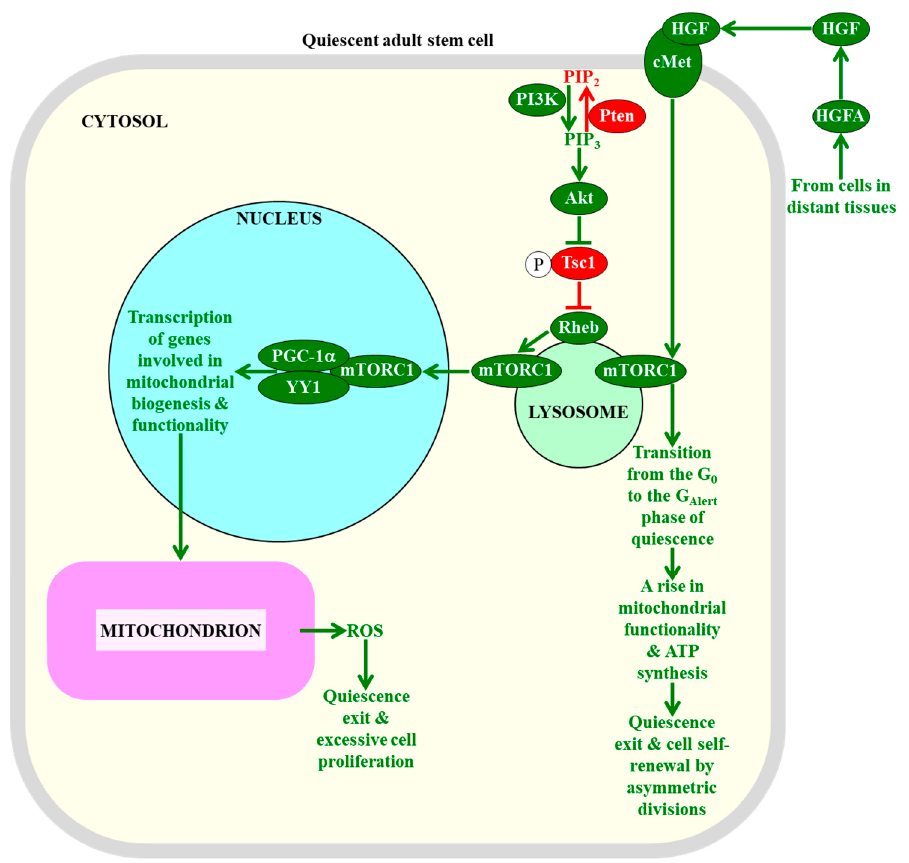
Figure 4. The intensity of information flow through the mTORC1-signaling pathway defines the fate of quiescent adult stem cells. A low intensity of mTORC1 signaling in adult stem cells decreases the extent of mitochondrial ROS production and release, thereby preventing the exit of these cells from the quiescent state and their excessive proliferation. An activation of mTORC1 signaling in response to hepatocyte growth factor, a cell-extrinsic pro-mitogenic signal, commits quiescent adult stem cells to cell cycle entry, proliferation, and differentiation. Proteins, metabolites, and processes whose activities, concentrations, and rates must be increased to maintain the quiescence of adult stem cells are displayed in red. Proteins, metabolites, and processes whose activities, concentrations, and rates need to be increased to promote the exit of adult stem cells from the state of quiescence are displayed in green. The red arrow defines the chemical reaction whose rate must be increased to maintain the quiescence of adult stem cells. The red inhibitory bar defines the inhibitory effect whose intensity must be increased to maintain the quiescence of adult stem cells. The green arrows define chemical reactions or processes whose rates or intensities must be increased to promote the exit of adult stem cells from the state of quiescence. See the text for more details. Abbreviations: Akt1, RAC-alpha serine/threonine protein kinase 1 or v-akt murine thymoma viral oncogene homolog 1; cMet, mesenchymal–epithelial transition factor; G Alert , the “alert” phase of quiescence; HGF, hepatocyte growth factor; HGFA, hepatocyte growth factor activator; mTORC1, the mammalian (or mechanistic) target of rapamycin complex 1; PGC-1 α , peroxisome proliferator-activated receptor-gamma coactivator 1 α ; PIP 2 , phosphatidylinositol 4,5-bisphosphate; PIP 3 , phosphatidylinositol (3,4,5)-trisphosphate; PI3K, phosphoinositide 3-kinase; Pten, phosphatase and tensin homologue; Rheb, Ras homolog enriched in brain; ROS, reactive oxygen species; Tsc1, tuberous sclerosis 1; YY1, yin-yang 1 transcription factor.